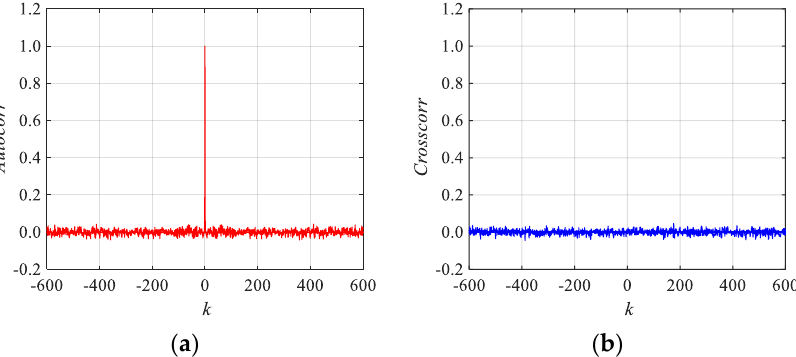
Figure 4. Correlation function of system (1): ( a ) Autocorrelation function; ( b ) Cross-correlation